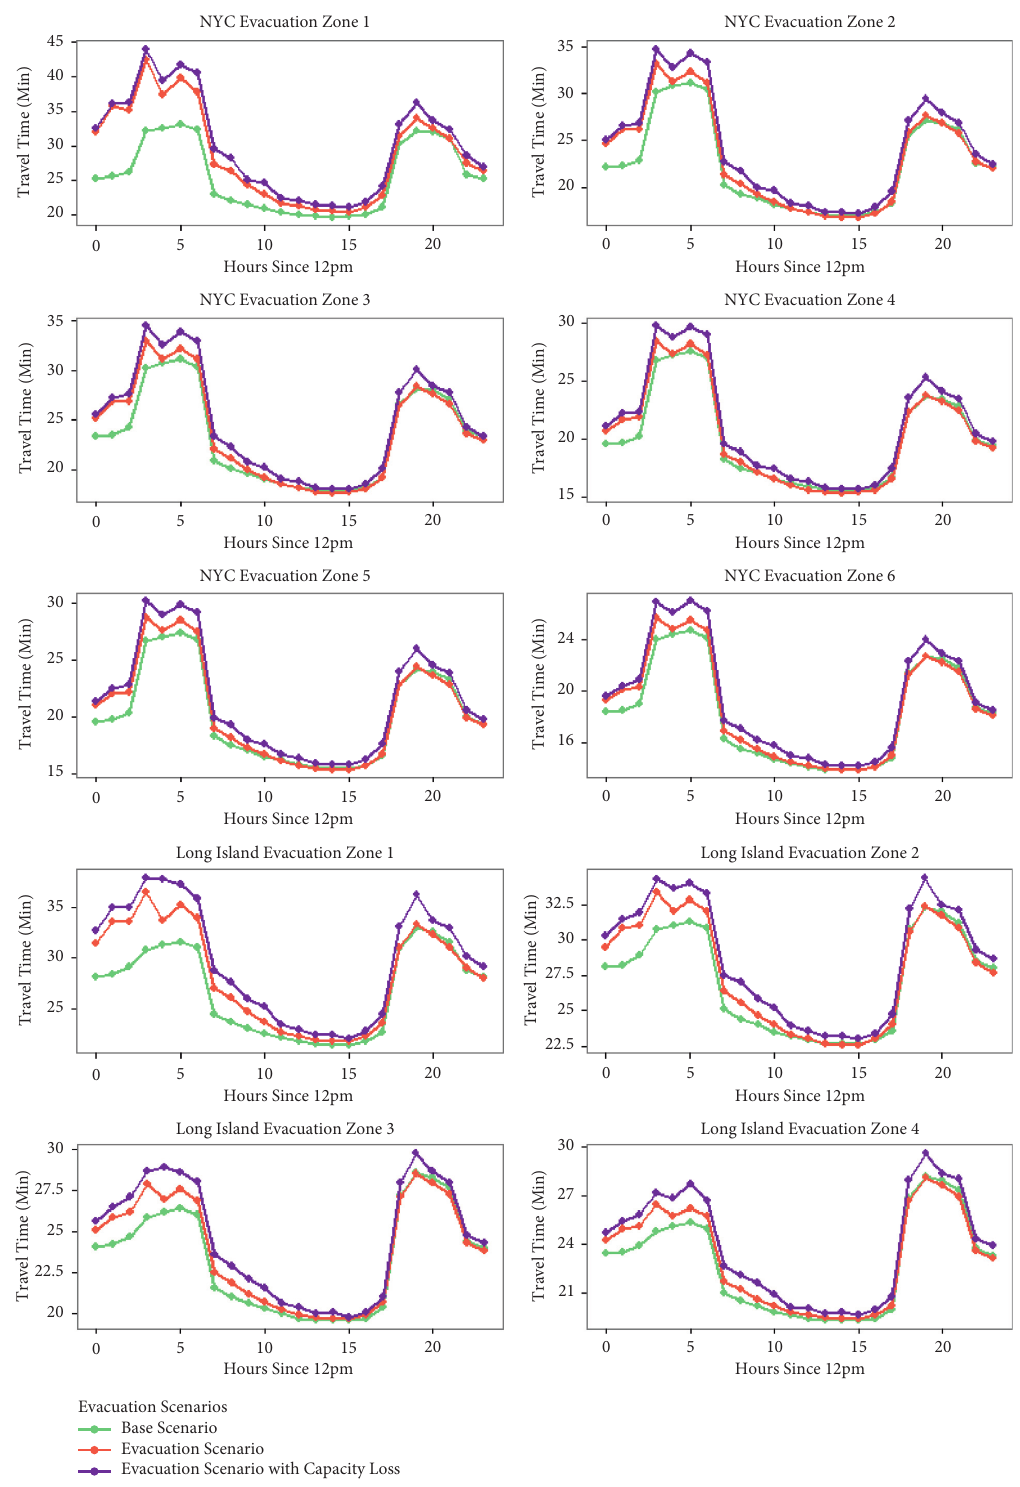
Figure 7: Comparisons of zonal travel times for different scenarios (in